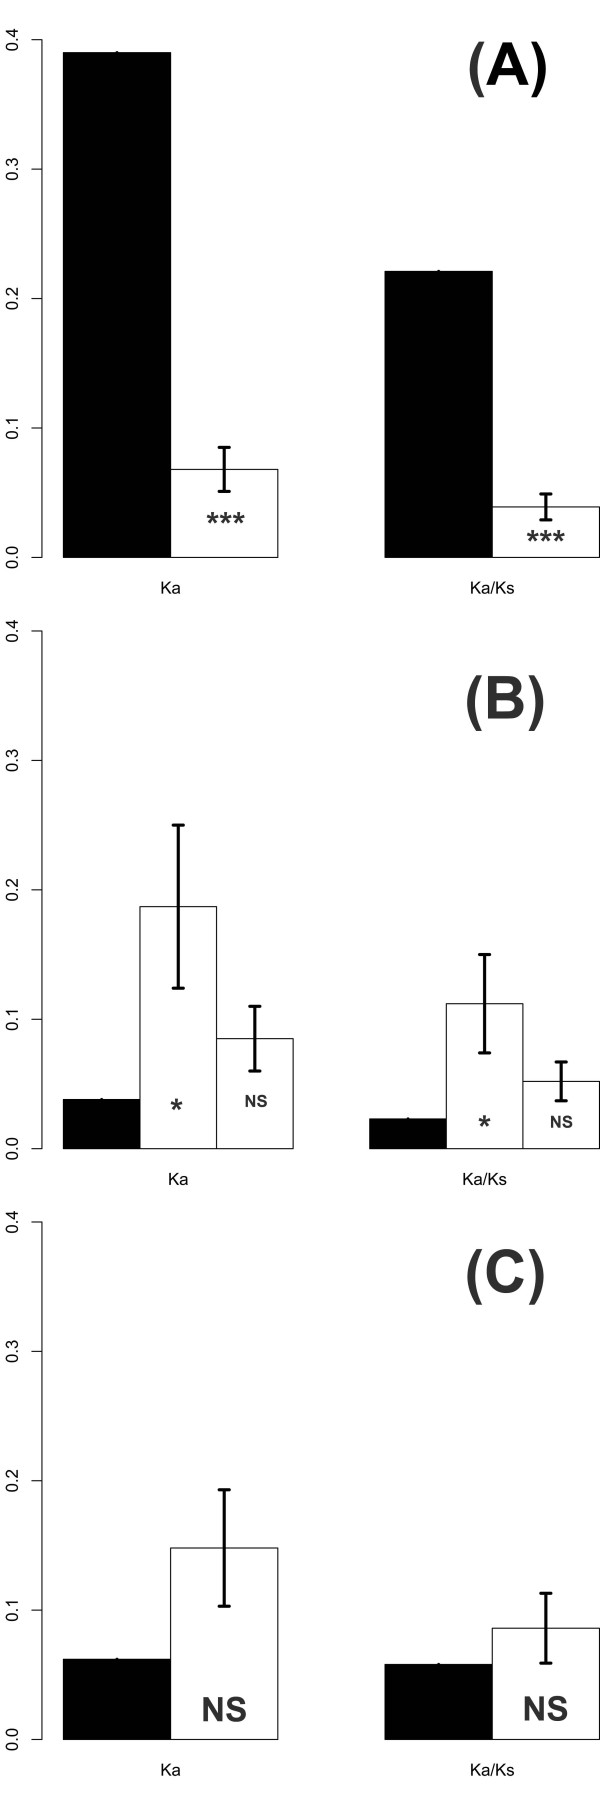
Observed (filled box) and simulated (open box) Ka and Ka/Ks values for VP1 (A), 2A (B), and 3C (C), respectively, between enterovirus (EV) 71-B4 and human enterovirus(HEV)-A. Simulated Ks values were set equal to the observations. The proportions of nonsynonymous (N) and synonymous (S) mutations were determined according to the observed N/S ratios in polymorphisms which were 0.10 for VP1, 0.24 and 0.12 for 2A, and 0.21 for 3C (see Table 2 and text for details). The error bar represents 1 standard deviation. p values were determined by 10,000 simulations. * p < 0.05; *** p < 0.001; NS, not significant (p > 0.05).